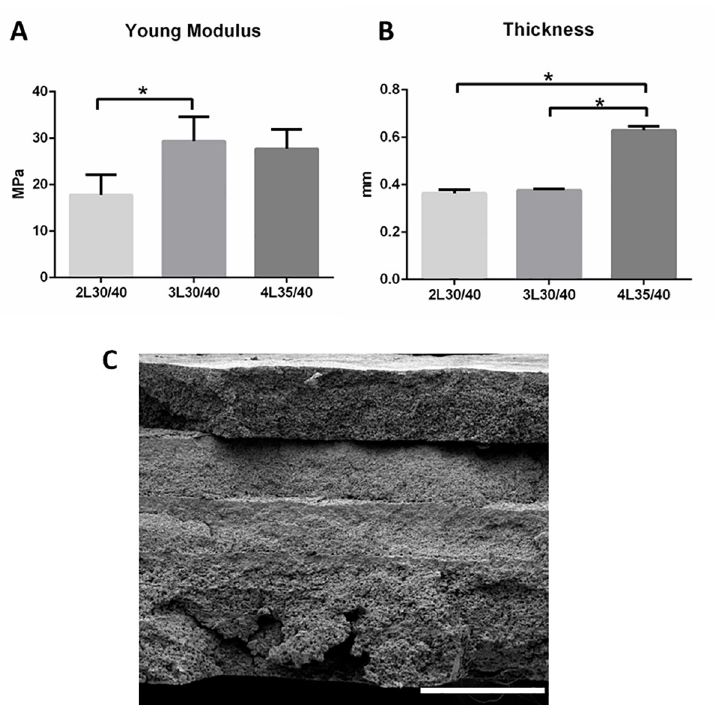
Fig 5. A) Young Modulus and B) thickness measurement for the different conditions (n = 3, � P < 0.05). C) FE-SEM images of the inner structure of 4L35/40 (scale bar = 300